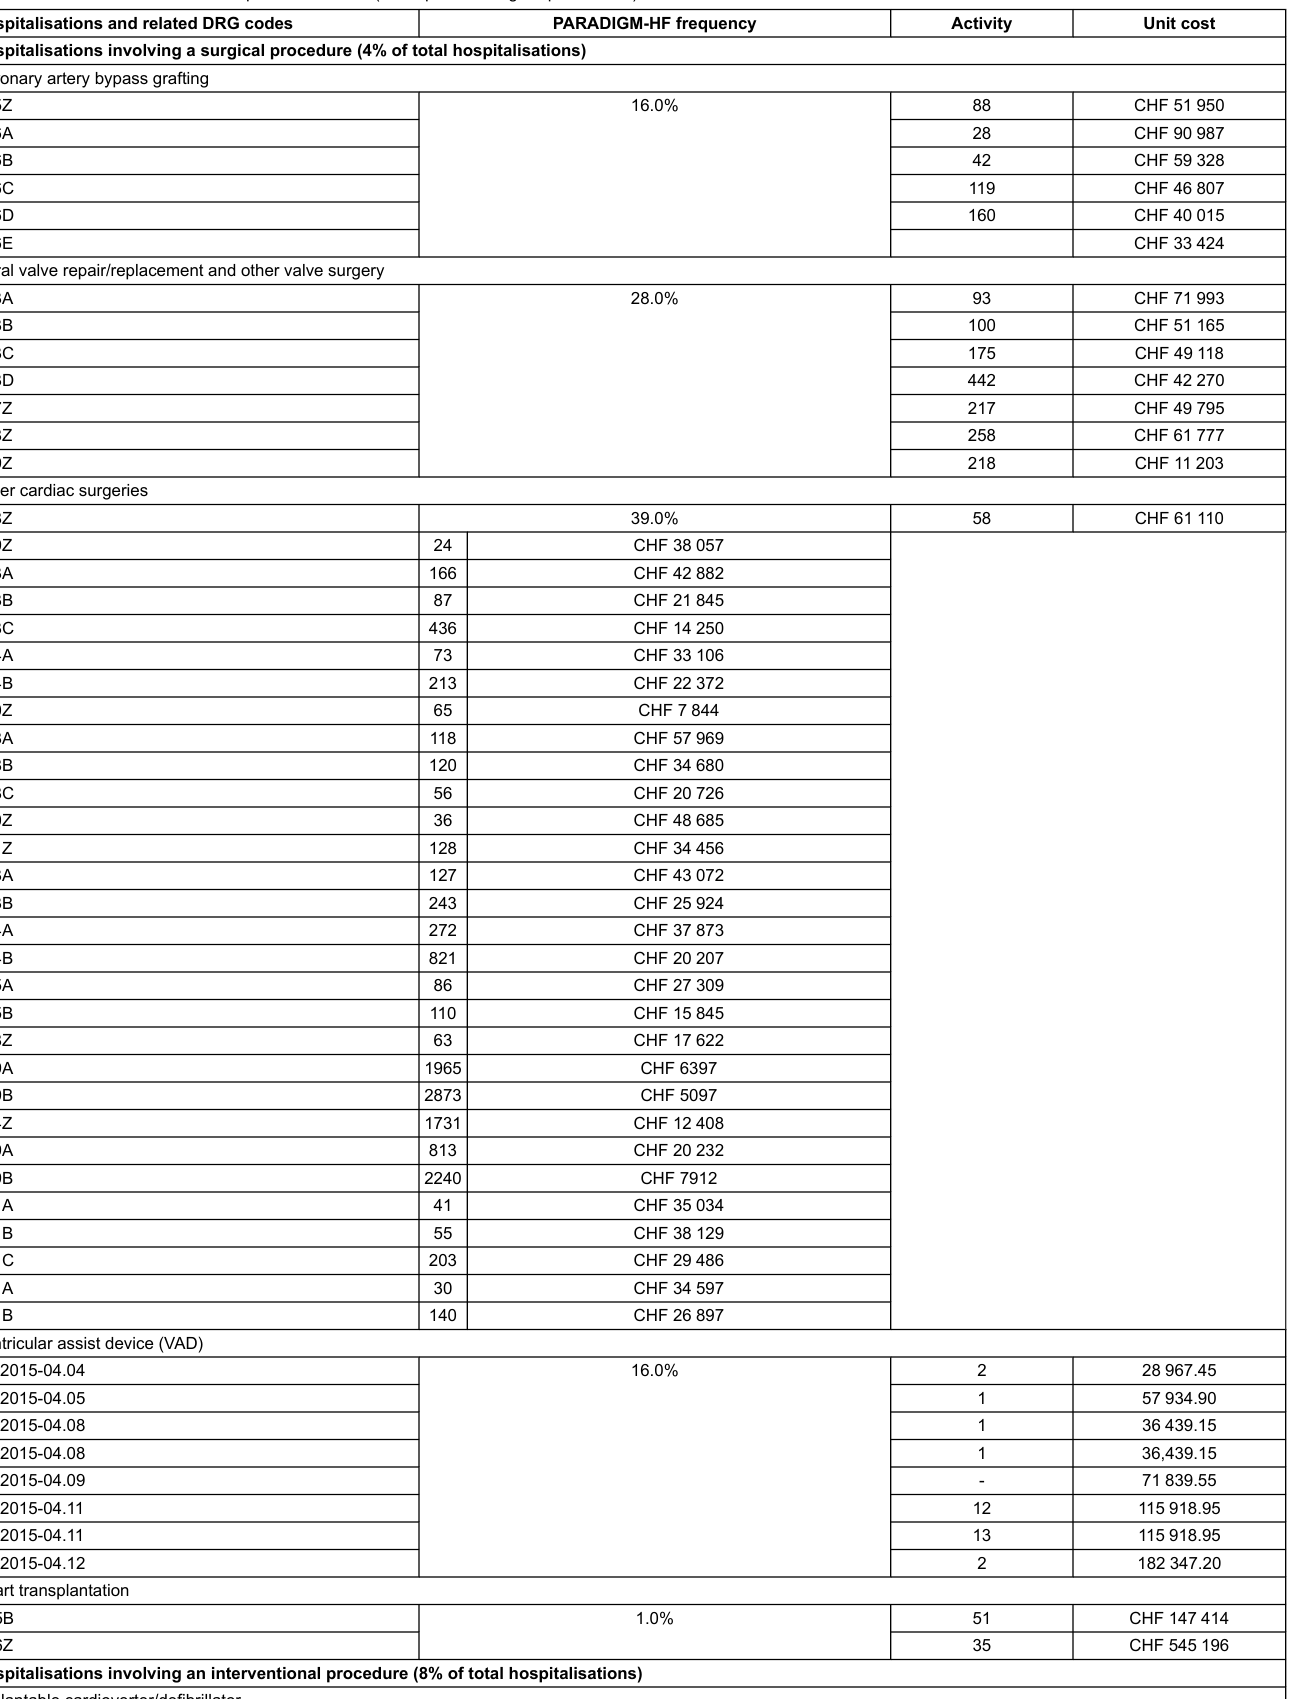
Table S11: Swiss DRG codes for hospitalisation costs (description of surgical